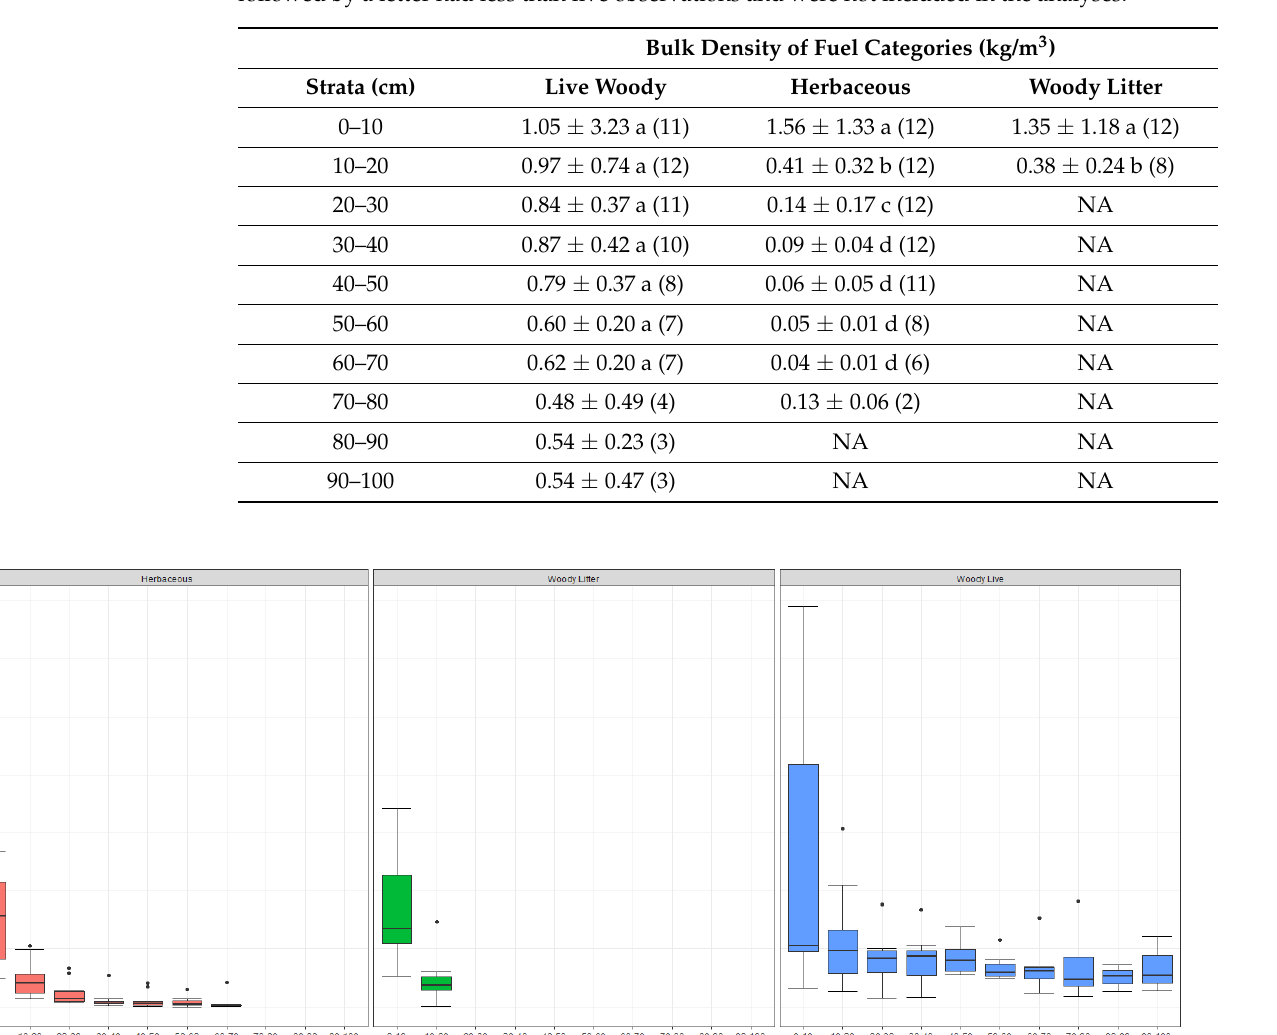
Table 1. Bulk density medians and interquartile ranges for the three fuel categories (live woody, herbaceous, and woody litter material) at each stratum (0–100 cm) with sample sizes in parentheses. “NA” indicates strata that either had no observations or a single observation where an average could not be calculated. All numbers represent the average bulk density at that stratum given in kg/m 3 . Medians within fuel categories are similar if followed by a common letter ( p > 0.05). Medians not followed by a letter had less than five observations and were not included in the analyses.